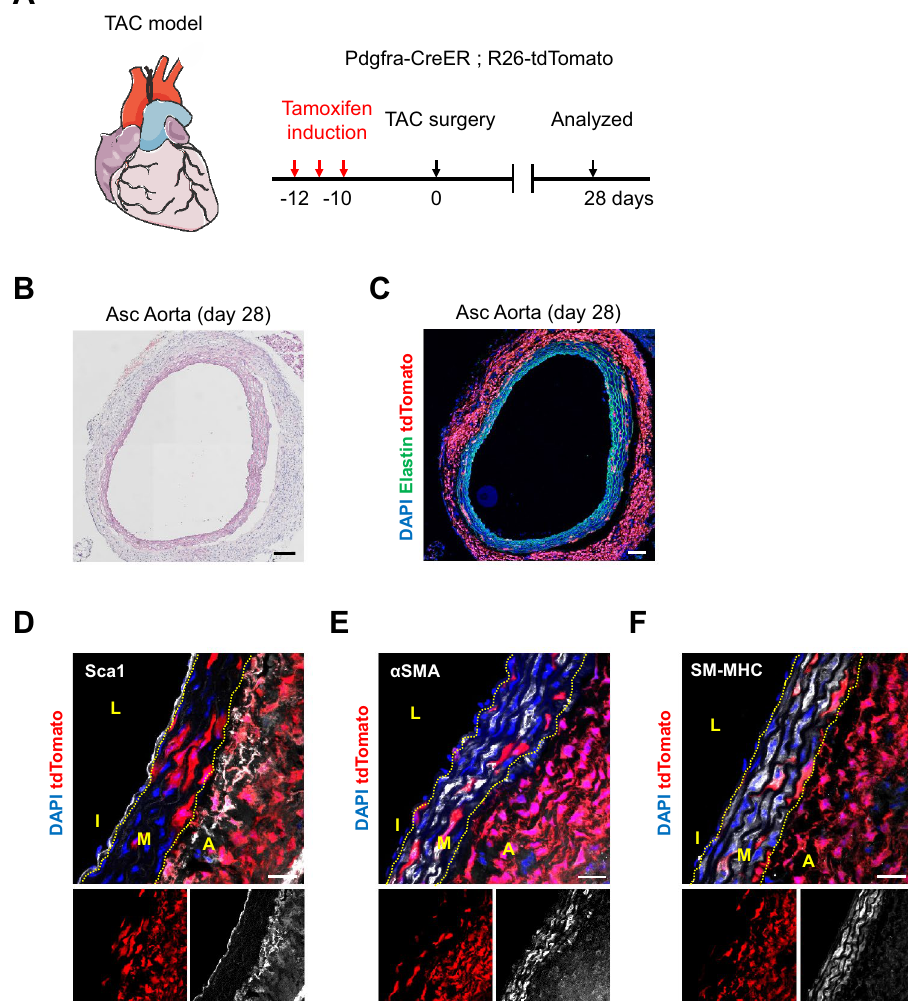
Figure 6. Pressure overload increased PDGFRa-derived cells in the adventitia. ( A ) Schematic outlining the experimental strategy. ( B ) Hematoxylin eosin-stained ascending aorta at 28 days after TAC surgery. Asc Aorta: ascending aorta. Scale bar: 100 µm. ( C ) Fluorescence image showing the distribution of tdTomato+ cells at 28 days after TAC surgery. Asc Aorta: ascending aorta. Scale bar: 100 µm. ( D – F ) Immunostaining for Sca1 ( D ), αSMA ( E ), SM-MHC ( F ) on ascending aorta sections at 28 days after TAC surgery. L: lumen, I: intima, M: media, A: adventitia, Asc Aorta: ascending aorta. Scale bars: 20 µm. See also Figure